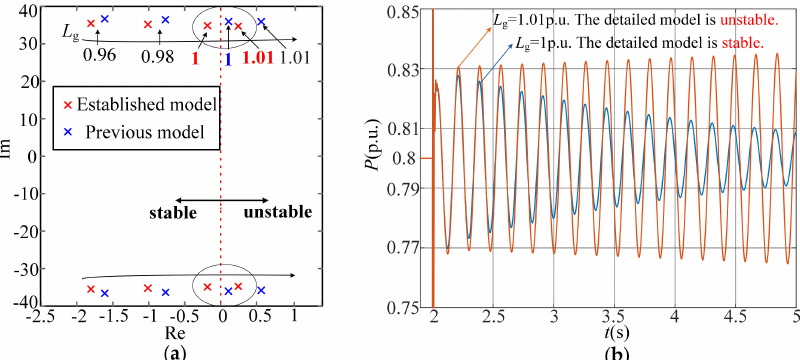
Figure 10. Comparisons of simulation responses between the established model, the previous nominal-frequency-based model, and the detailed model when the phase of U g decreases 5 ◦ at 2s.